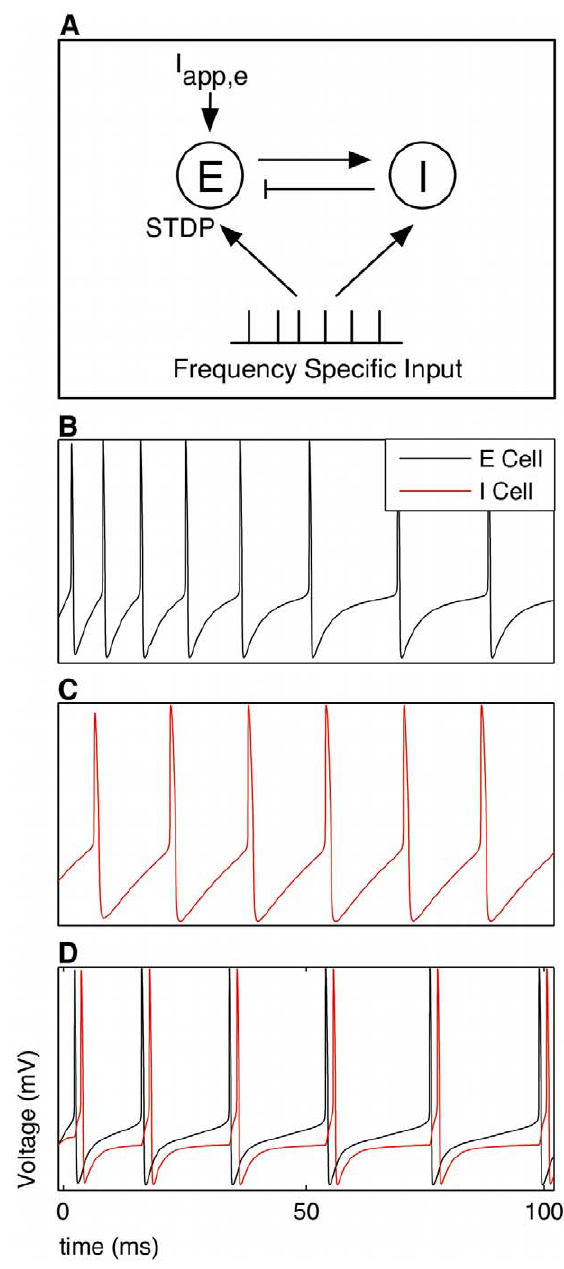
Figure 1. Network model generates gamma rhythms indepen- dently and receives gamma frequency input. (A) An excitatory regular spiking pyramidal cell (E) is mutually coupled with a fast spiking inhibitory basket cell (I). The E and I cells are single compartmental Hodgkin-Huxley type neurons. The E-I network is driven by I app , e to spike at gamma frequencies. Both cells receive an input consisting of discrete spike times at gamma frequencies. Plasticity occurs only at the E cell synapse via STDP, manifested by changes in the AMPAR conductance. (B) The E cell is modeled after a regular spiking pyramidal cell in primary sensory cortex. It exhibits spike frequency adaptation when driven with an applied current. (C) The I cell is modeled after a fast spiking inhibitory basket cell that displays no spike frequency adaptation when driven with an applied current. (D) The coupled E-I oscillator can exhibit pyramidal-interneuronal gamma (PING) rhythms when the E cell is driven by an externally applied current. The I cell is not driven tonically in the simulations.